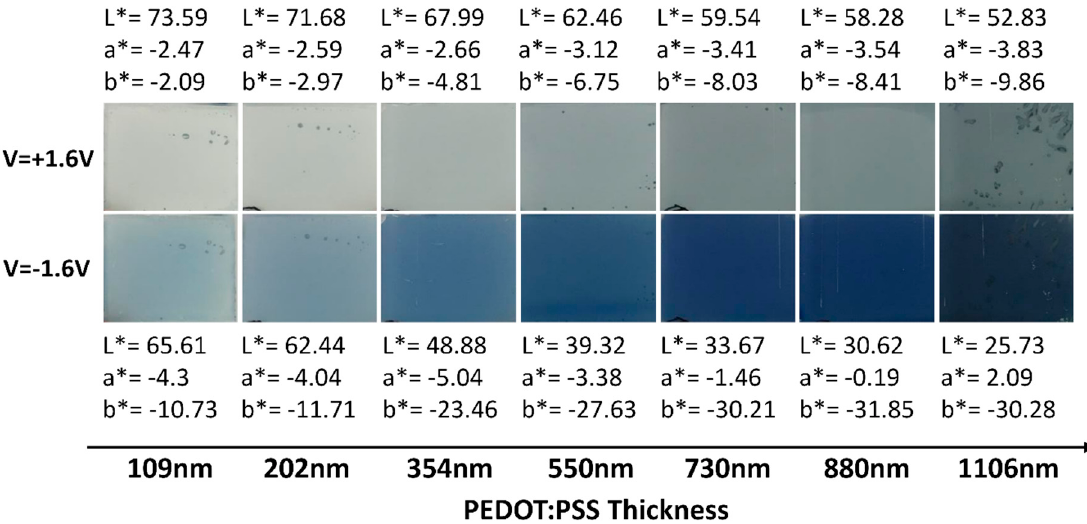
Figure 1. ( a ) Cyclic voltammograms of the electrochromic symmetrical displays built from PEDOT:PSS thin films with varying thickness from 109 nm to 1106 nm, ( b ) chronoamperograms ( CA ) of the electrochromic symmetrical displays built from different PEDOT:PSS thicknesses. Potentials of +1.6 V and − 1.6 V were applied for 30 s alternatively.